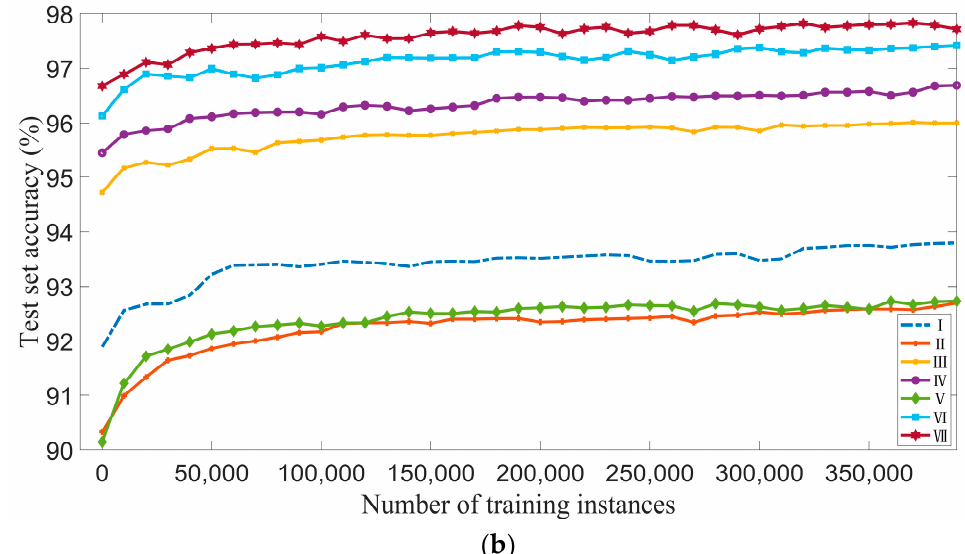
Figure 4. The overall accuracy of different SVM model experiments in ( a ) Arctic and ( b ) Antarctic regions.